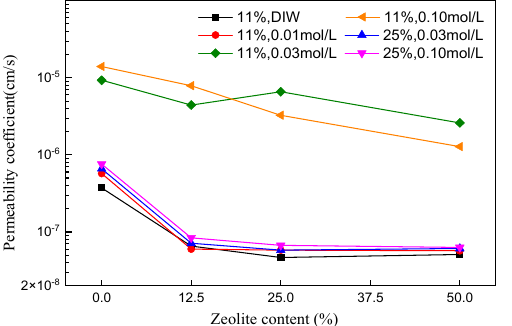
Figure 6. Effect of simultaneous variation of ZnCl 2 concentration and zeolite admixture on the permeability coefficient of mixed soils .